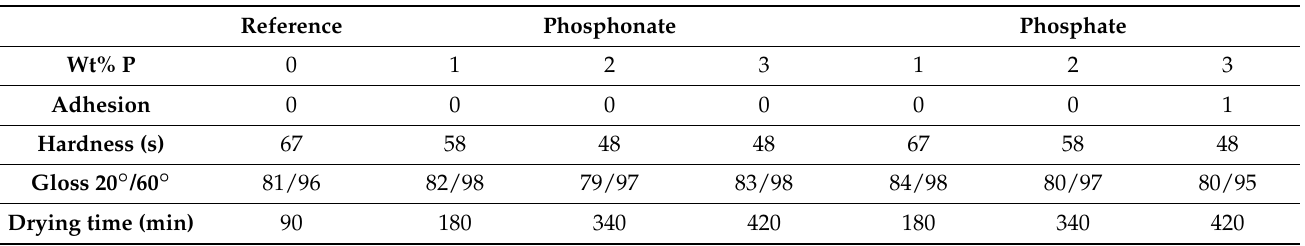
Table 6. Adhesion, hardness, gloss and drying time of phosphorylated cardanol reactive diluent alkyd resins.